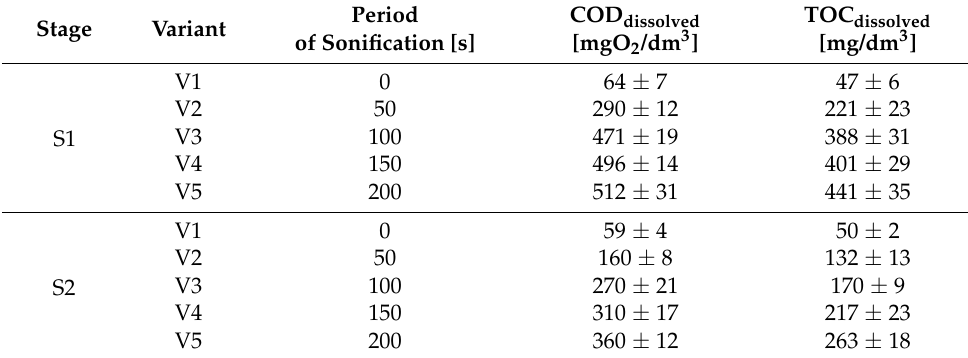
Table 1. Indicators of dissolved organic